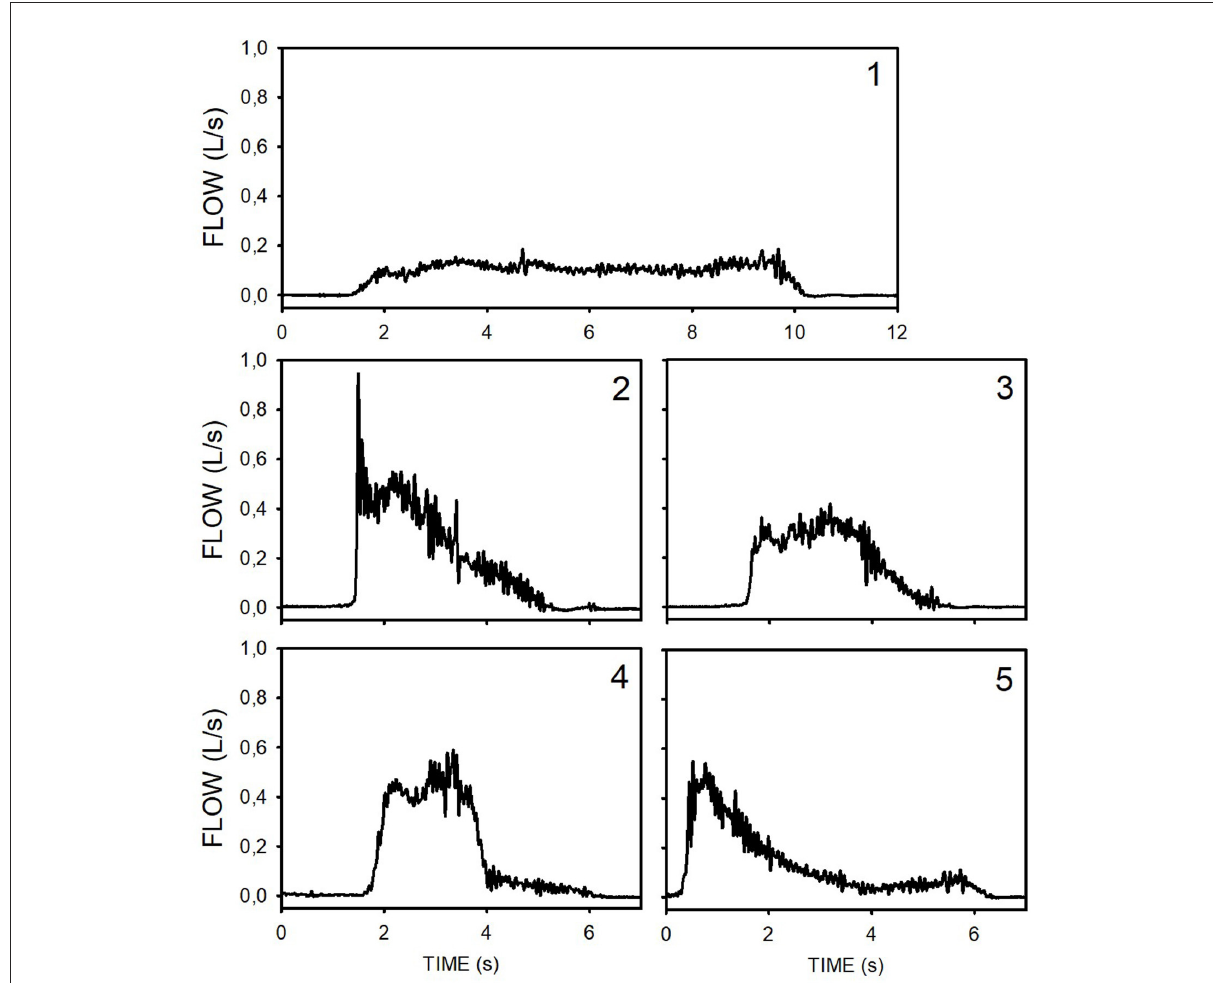
FIGURE4 Time course of flow along the four maneuvers carried out manually with the resuscitation bag to calibrate the low-cost pneumotachograph. These flow signals were measured with a reference pneumotachograph. The number of maneuver (1–5) corresponds to those in Table 2.